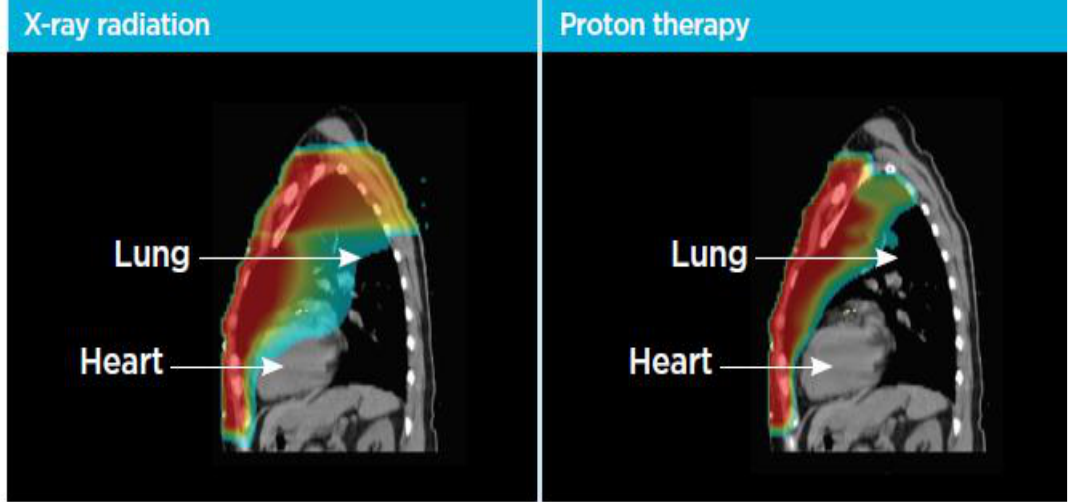
Figure 3. An illustration highlighting differences in cardiac and pulmonary structures with the use of photon radiotherapy versus proton radiotherapy (Figure courtesy of Dr. T.G. Neilan).